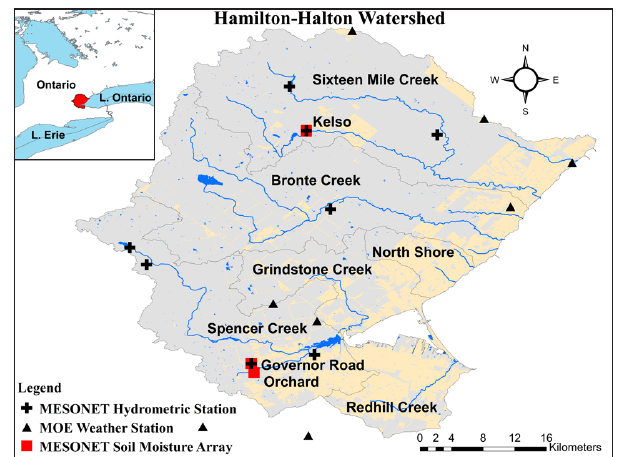
Fig. 1. Location map of the Hamilton-Halton Watershed includ- ing subwatersheds and the locations of the soil moisture arrays and hydro-meteorological